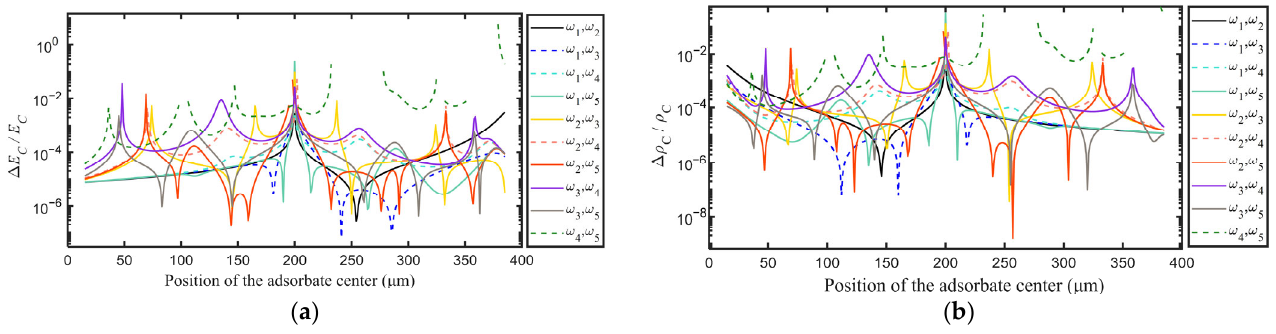
Figure 3. The relative physical parameter errors of the polymer adsorbate when 0.001% frequency error were added to the first five order natural frequencies. ( a ) Young’s modulus errors, ( b ) Density errors.